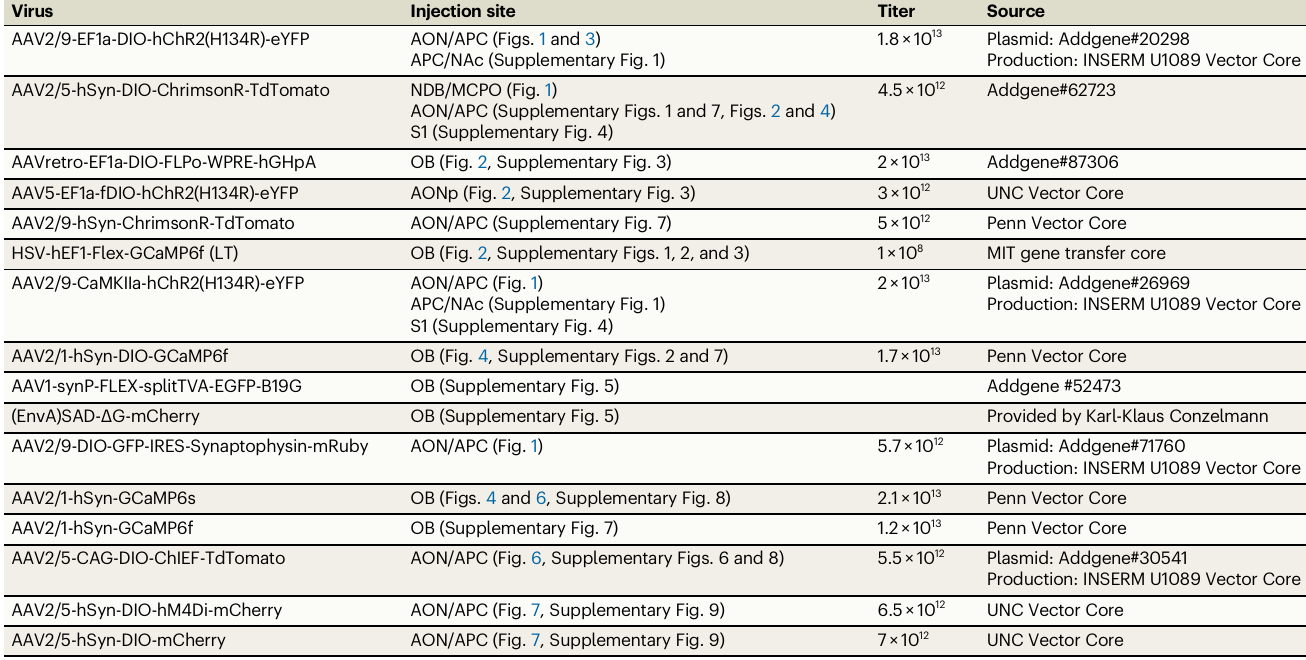
Table 1 | Details of the viruses used Virus Injection